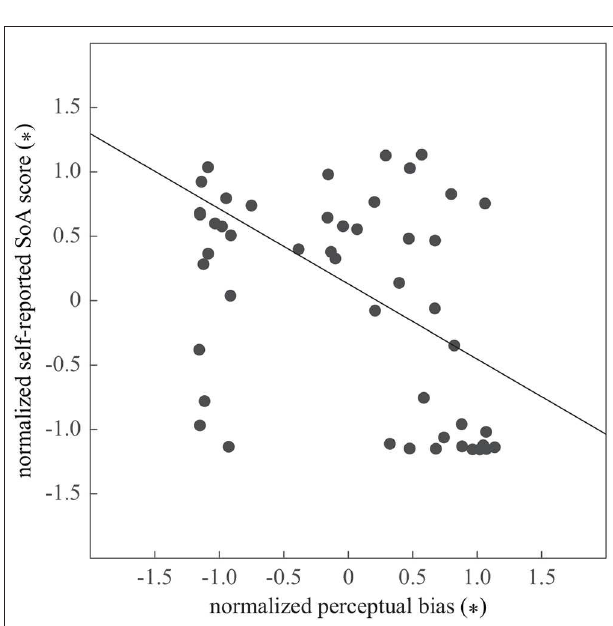
incorrect direction ( − 46.9 ± 90.8 ms). This IBE-like observation